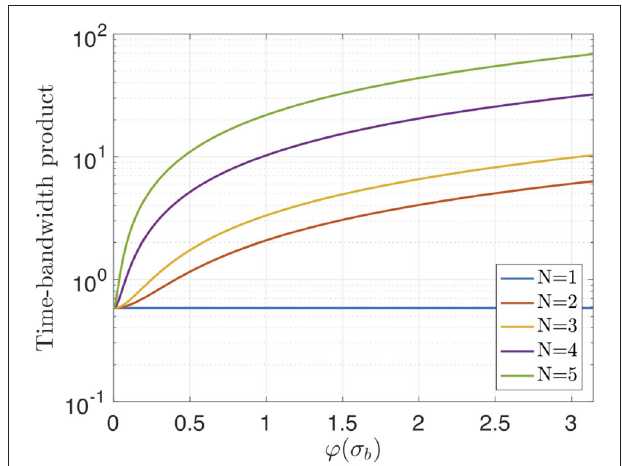
FIGURE 5 | Time-bandwidth product as a function of the phase change over the rms bunching envelope ϕ ( σ b ) Equation